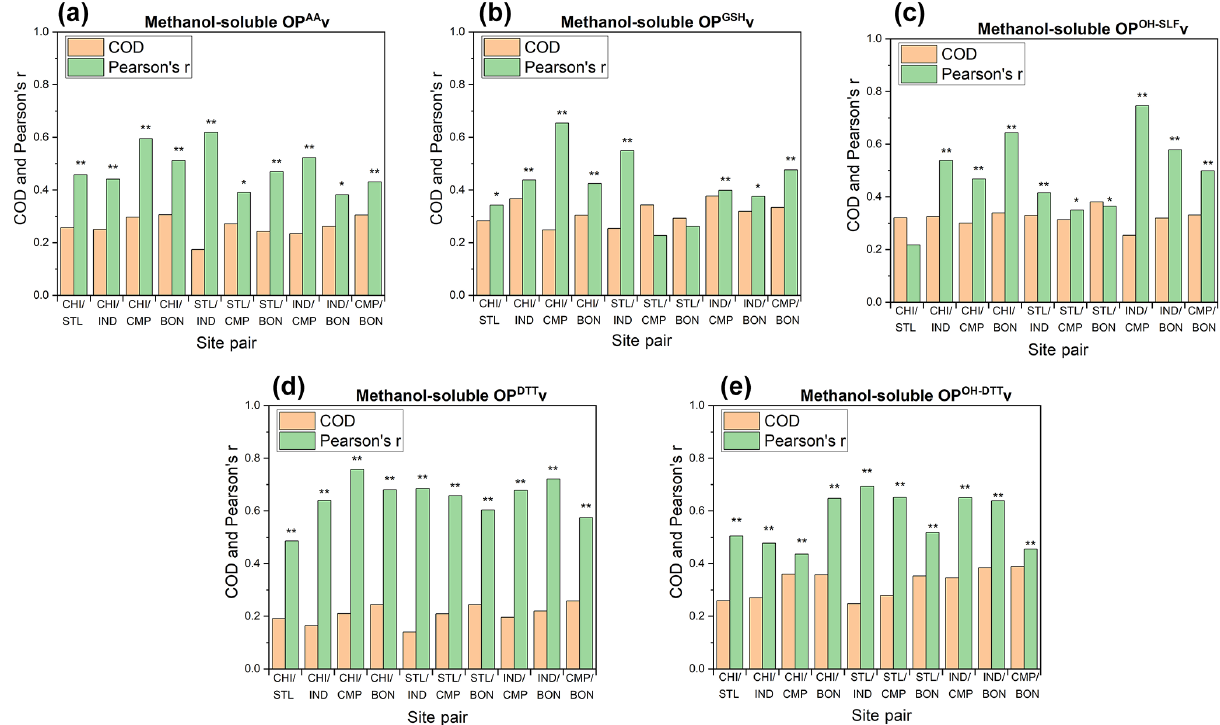
Figure 9. Coefficient of divergence (CoD) and Pearson’s r for site-to-site comparison of methanol-soluble OP activities: (a) OP AA v, (b) OP GSH v, (c) OP OH − SLF v, (d) OP DTT v ,and (e) OP OH − DTT v. Single asterisks ∗ and double asterisks ∗∗ on the bars of Pearson’s r indicate significant ( P < 0 . 05) and very significant ( P < 0 . 01) correlations,